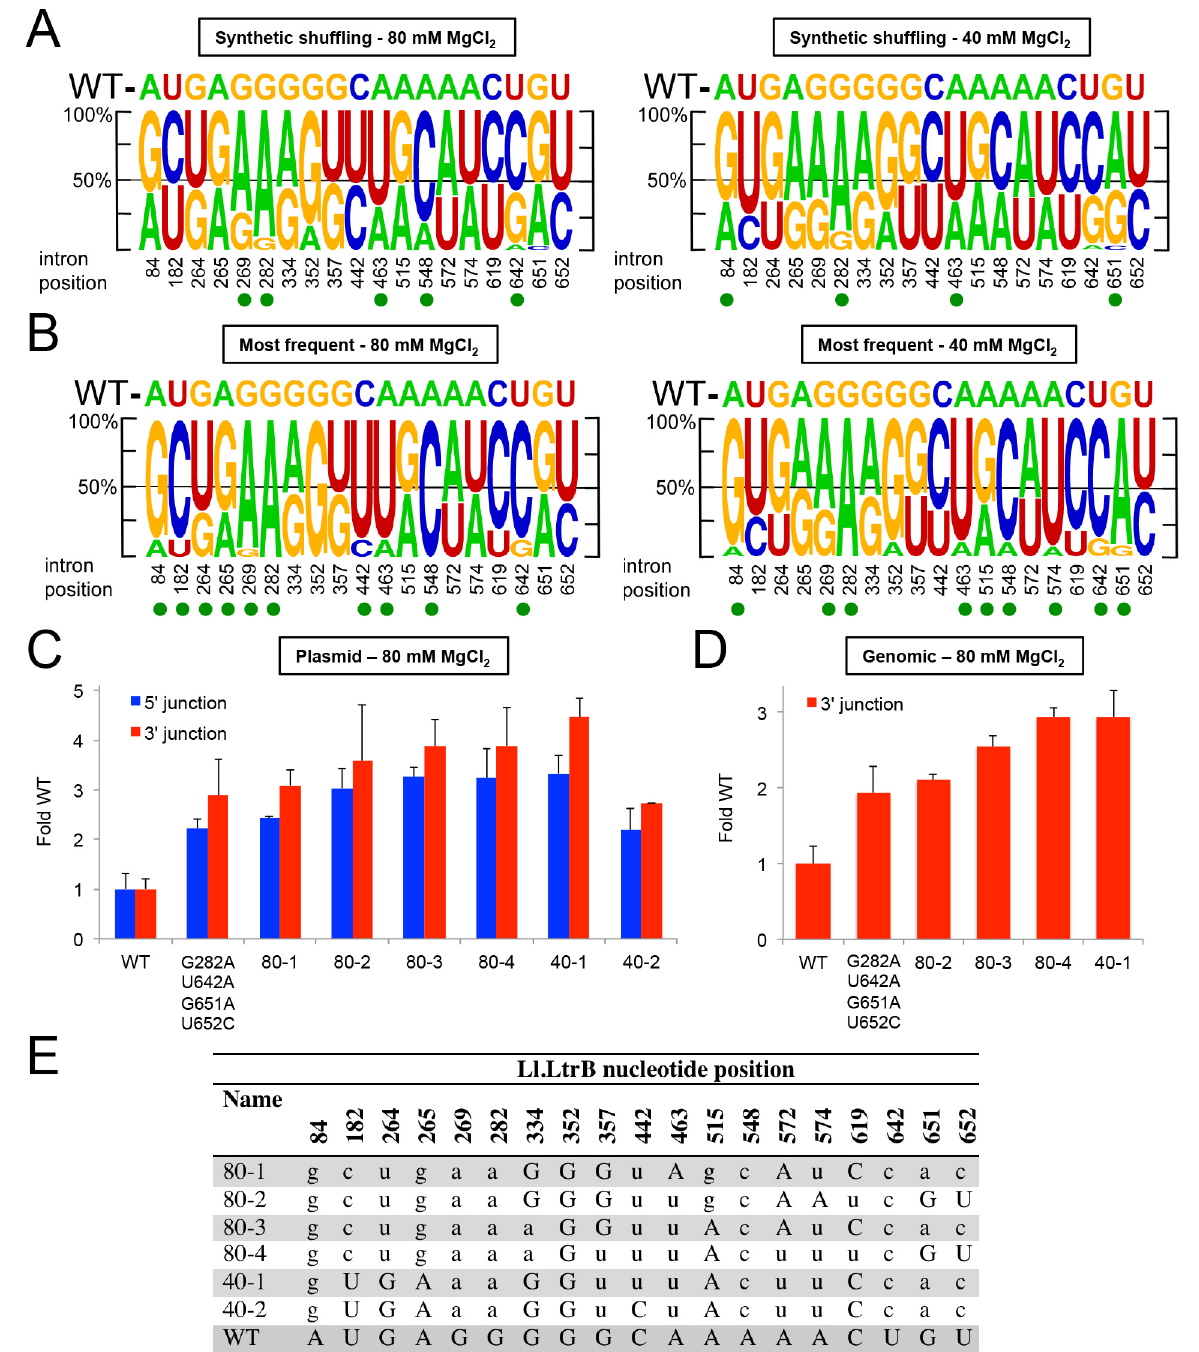
Fig 9. Synthetic shuffling of positively selected mutations identifies Ll.LtrB variants with enhanced retrohoming into plasmid and chromosomal target sites in human cells. Optimal combinations of mutations were identified by the recombination-based technique of synthetic shuffling. A synthetic shuffling library of Ll.LtrB variants was constructed in which mutations at 18 positions that were under positive selection ( > 80% of one nucleotide type in > 5% of the population in selection rounds 8 or 12 (subsets of the nucleotides indicated by green triangles or green or black arrows in Fig 7) were doped fifty percent against the wild-type nucleotide and position 642 was randomized. Sanger sequencing showed that the starting frequency of each nucleotide in the initial library was as expected for the degree of doping or randomization. The introns were selected in HEK-293 cells for four cycles of retrohoming (S7 Fig) with either 80 or 40 mM MgCl 2 added to the culture medium. Pacific Biosciences RS circular consensus sequencing was used to identify the